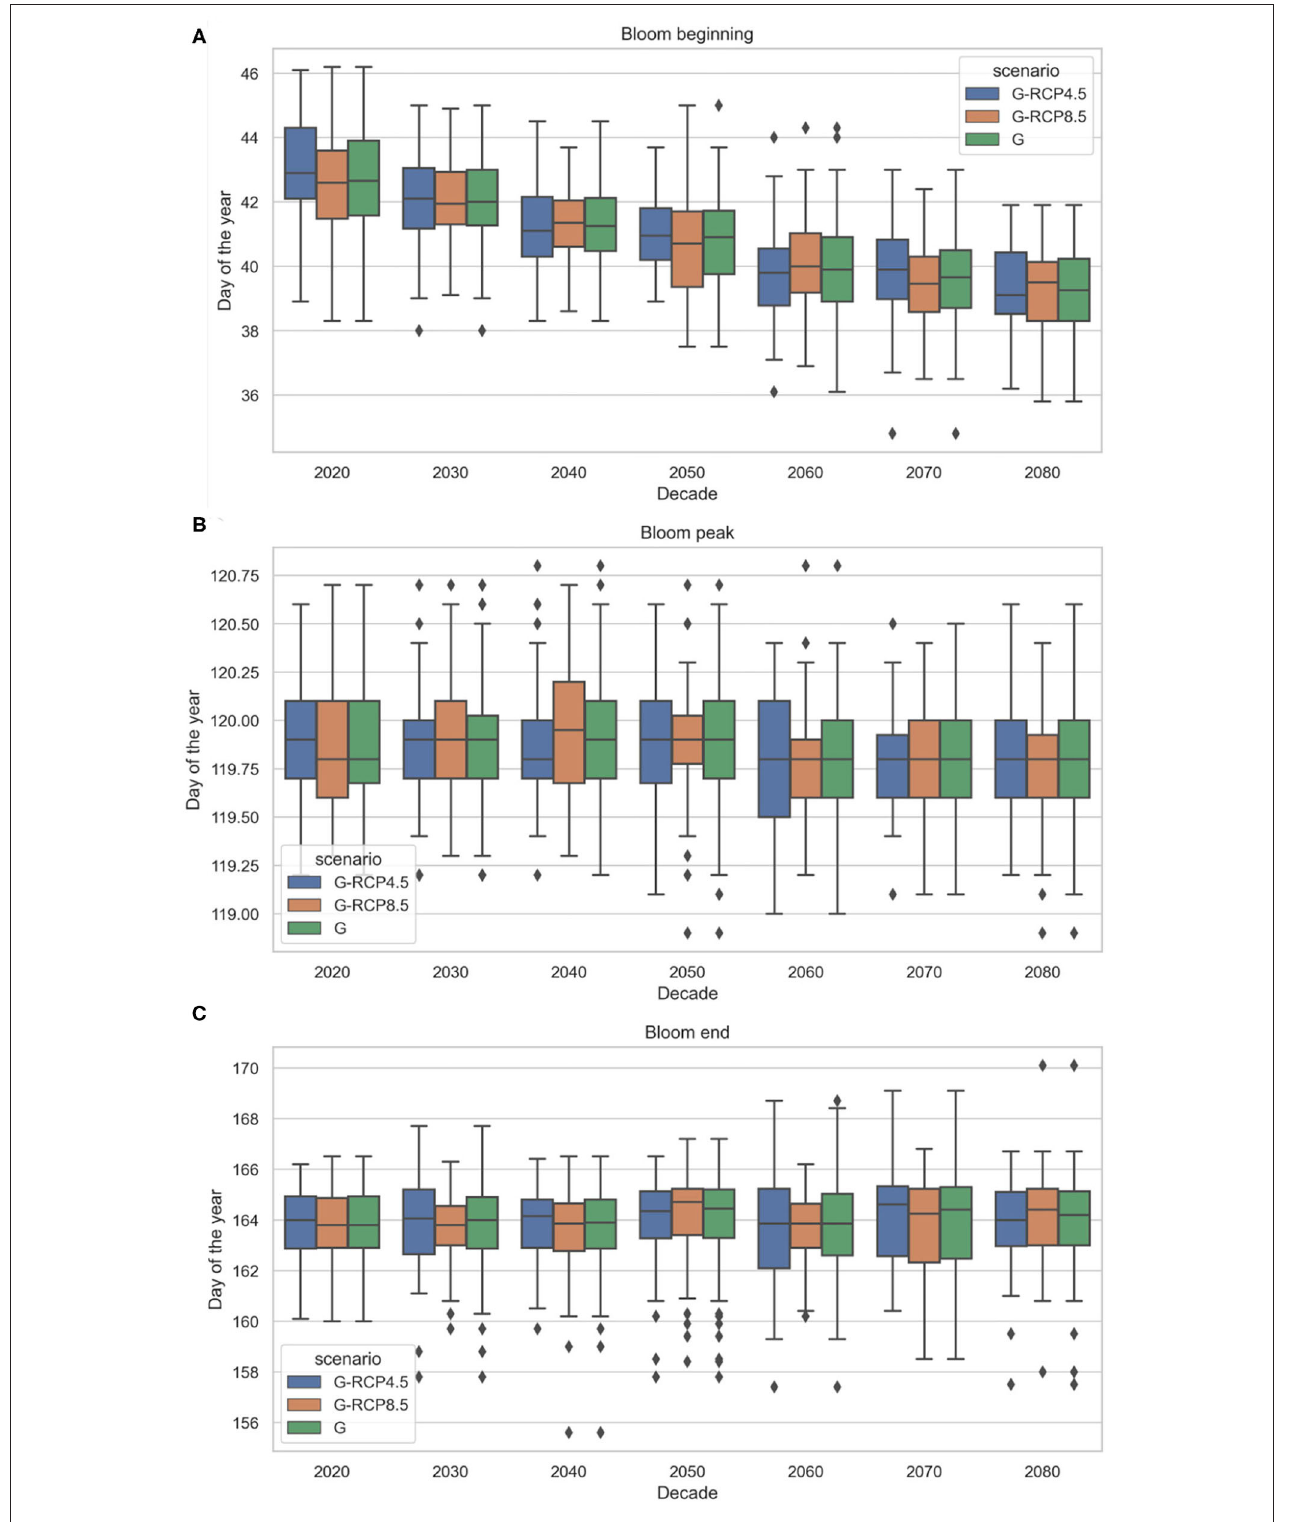
FIGURE 14 | Projected future phytoplankton spring bloom beginning (A) , peak timing (B) , and end (C) under generated (G) radiation and temperature projections (based EURO-CORDEX) (2019–2089). The cardinal dates are grouped based on all generated projections (G), and generated projections corresponding to RCP scenarios (G-RCP4.5 and